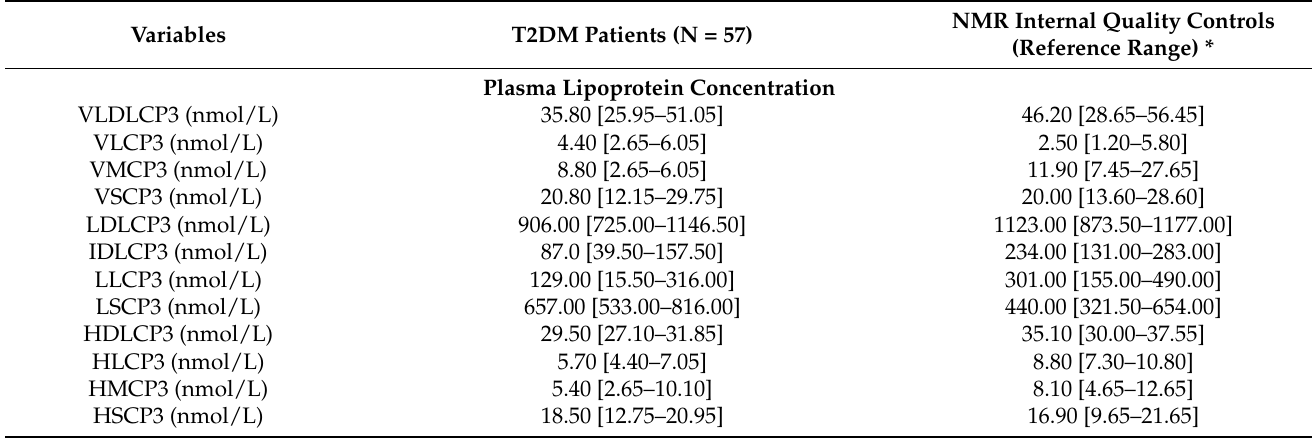
Table 2. Plasma levels of NMR-derived lipoprotein subpopulations and markers for insulin resistance and inflammation in T2DM